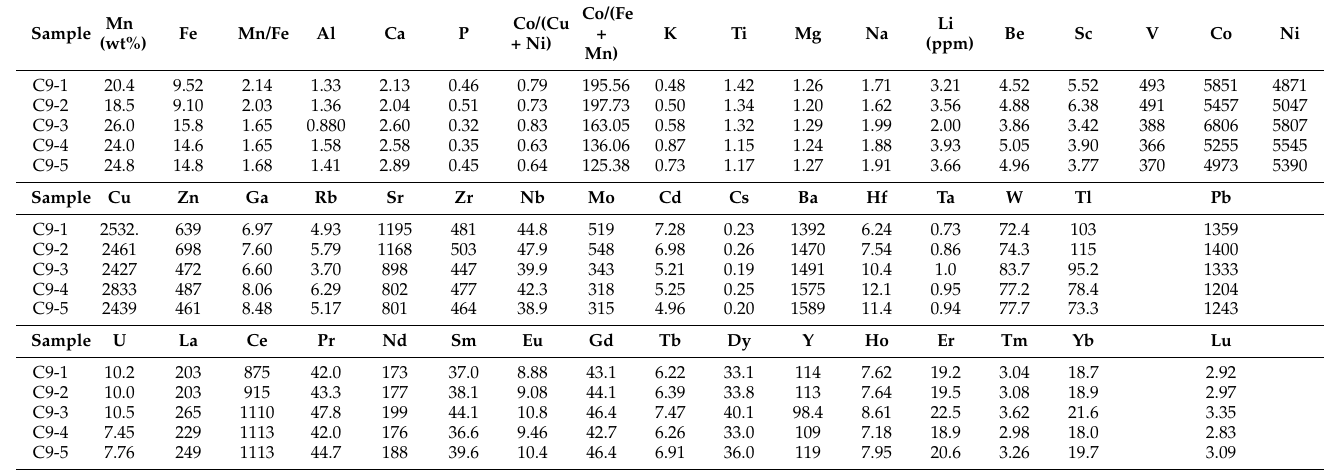
Table 3. Geochemistry compositions of the ferromanganese